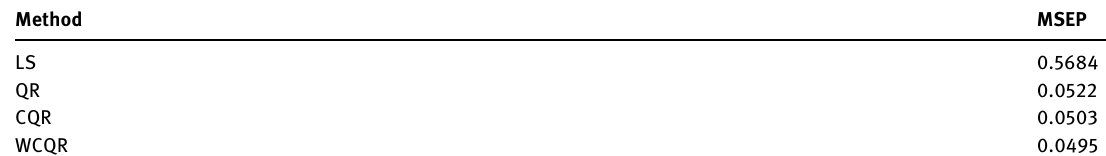
Table 7: MSEPs for di ff erent methods